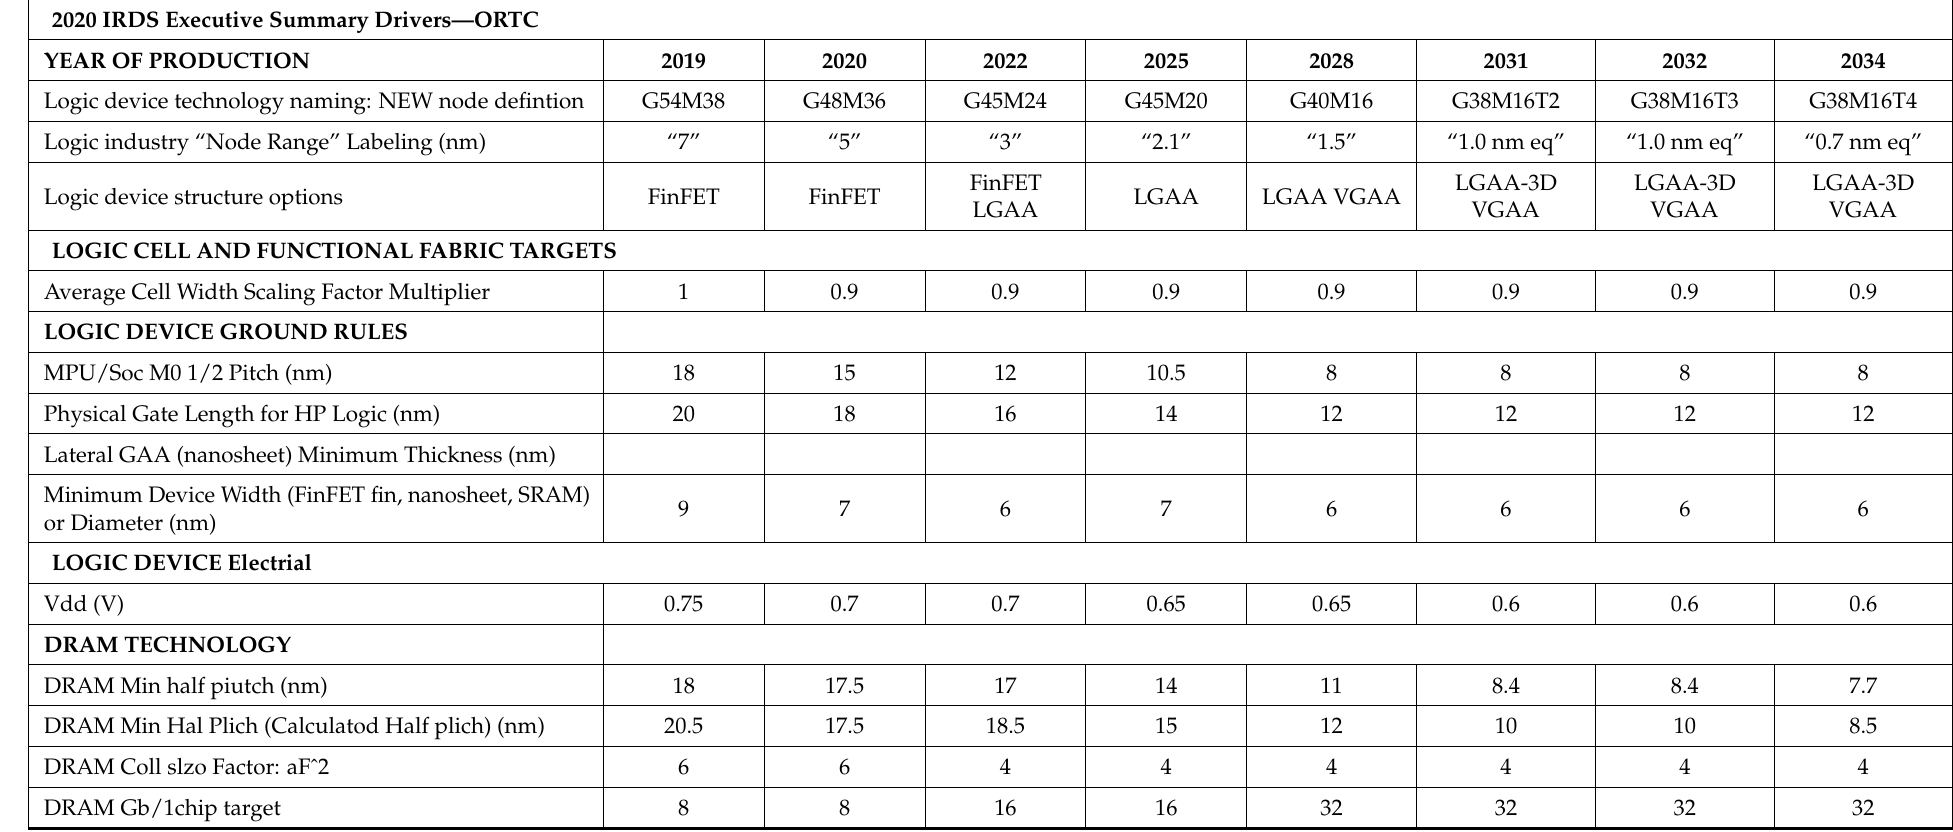
Table 2. Overall Roadmap Technology